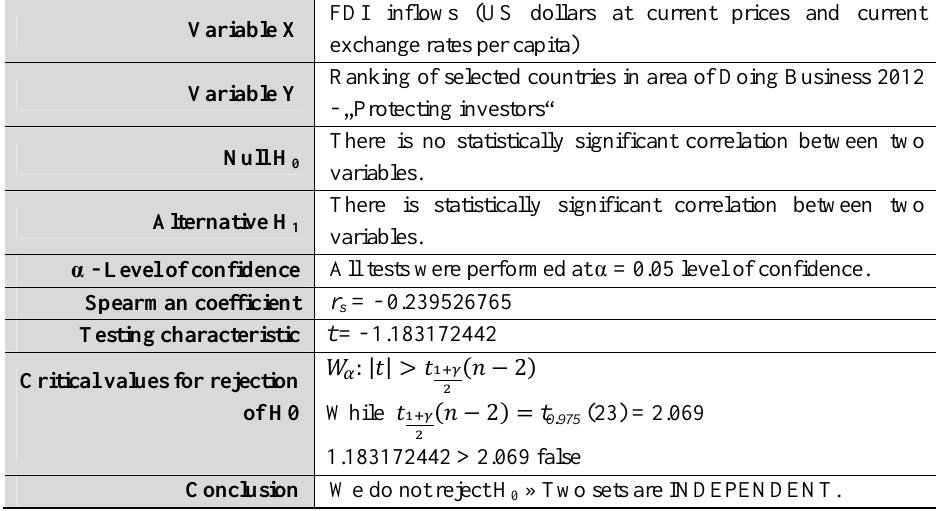
(Table 3) means, that between FDI inflow in a country and values of “Protecting investors“ should be negative correlation, but the value of coefficient approaches to 0. By calculation of tested characteristic and by finding out the respective value of Student’s t-distribution, we came to the inequality t (23) = 2.069. As the inequality is false, hypothesis H 0.975 ($ − 2) = (cid:27) !"# (cid:9)